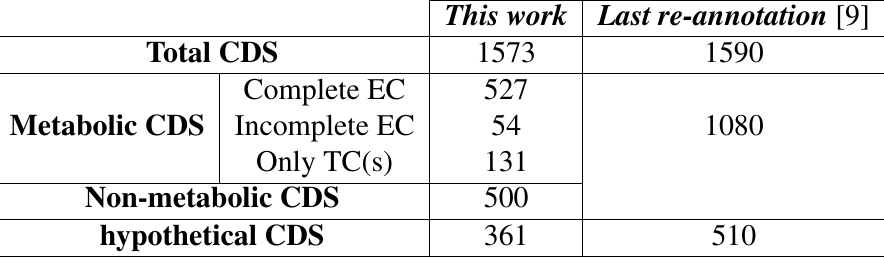
Table 1: Distribution of CDS according to functional category This